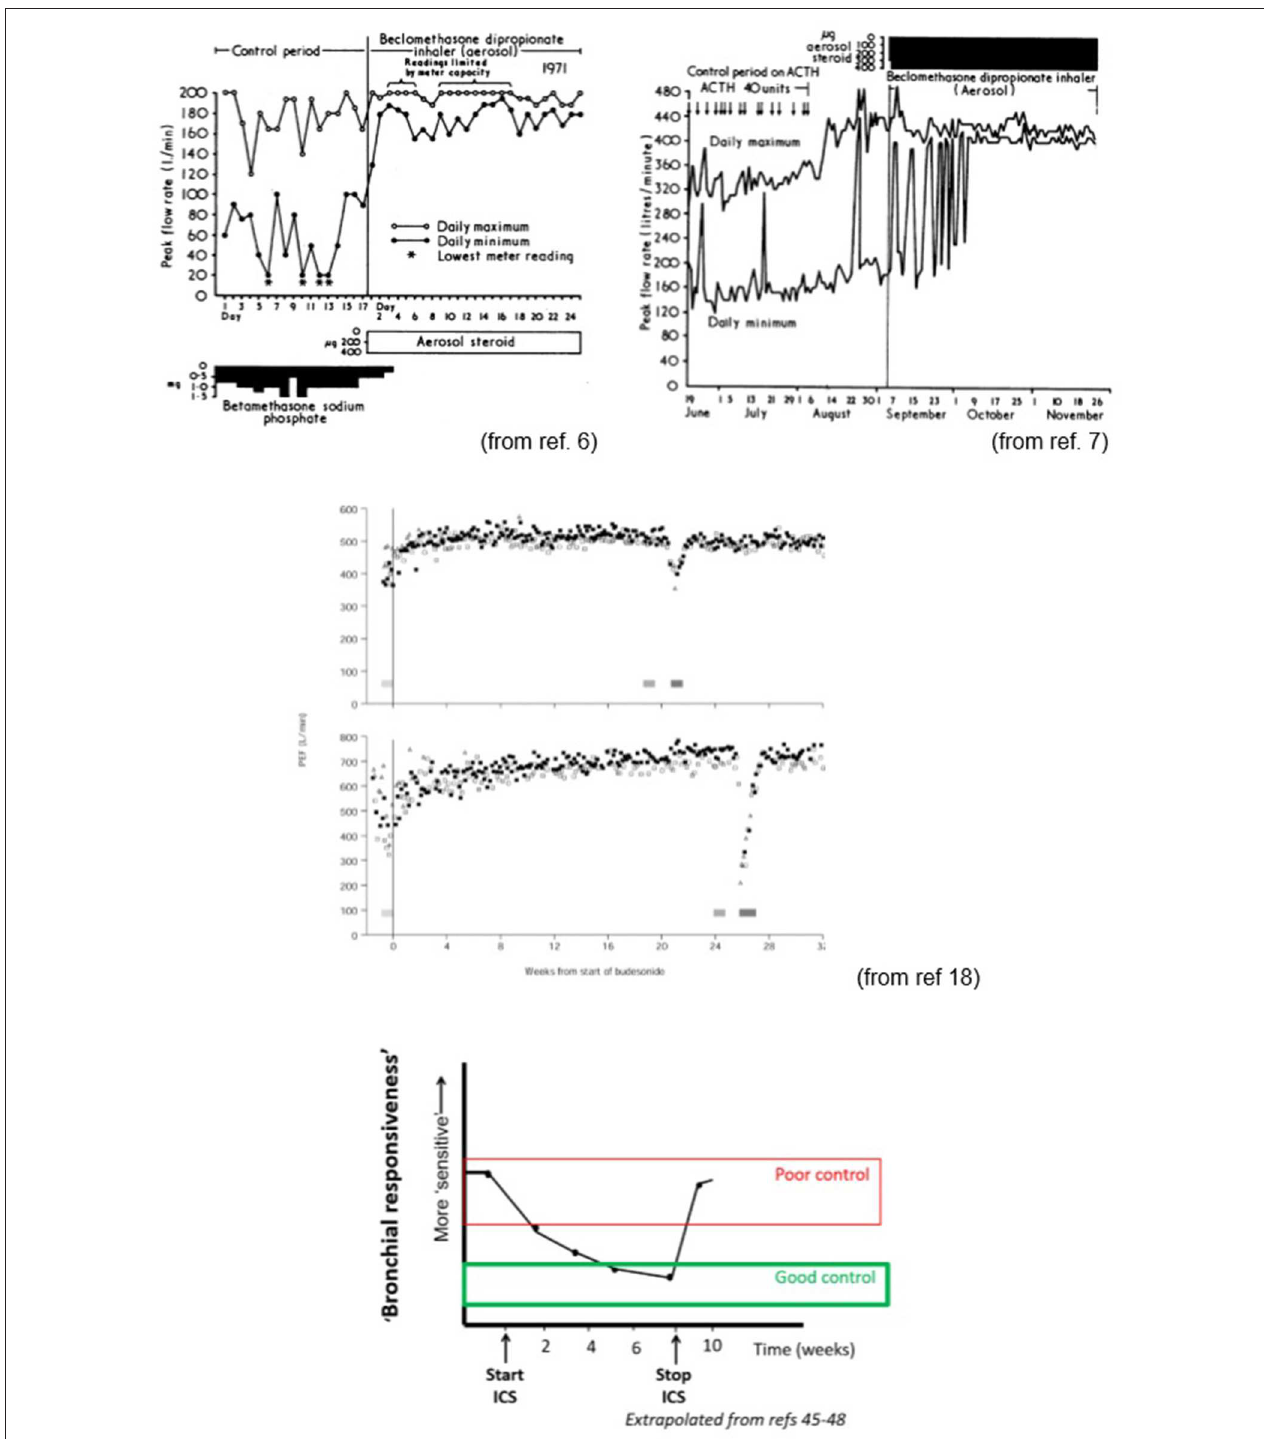
FIGURE 3 | Impact of inhaled corticosteroids on lung function and bronchial responsiveness (sensitivity). Impact on sensitivity is relatively slow when commencing ICS but rapidly fades on discontinuing treatment. This largely explains the need for high levels of compliance ( > 80% of twice daily doses). Study by Reddell et al. (middle panels) indicates that even when asthma appears well controlled, ASM homeostasis can be severely disrupted during viral infections. The ability to induce/facilitate bronchoconstriction and the associated impaired bronchodilator responsiveness after the airways constrict might explain why the Finnish/Scandinavian approach of aggressive bronchodilator and ICS therapy early at first sign of increasing symptoms is successful at minimizing severe exacerbations and why combination products used intermittently appear to be helpful in mild to moderate asthmatics (65).